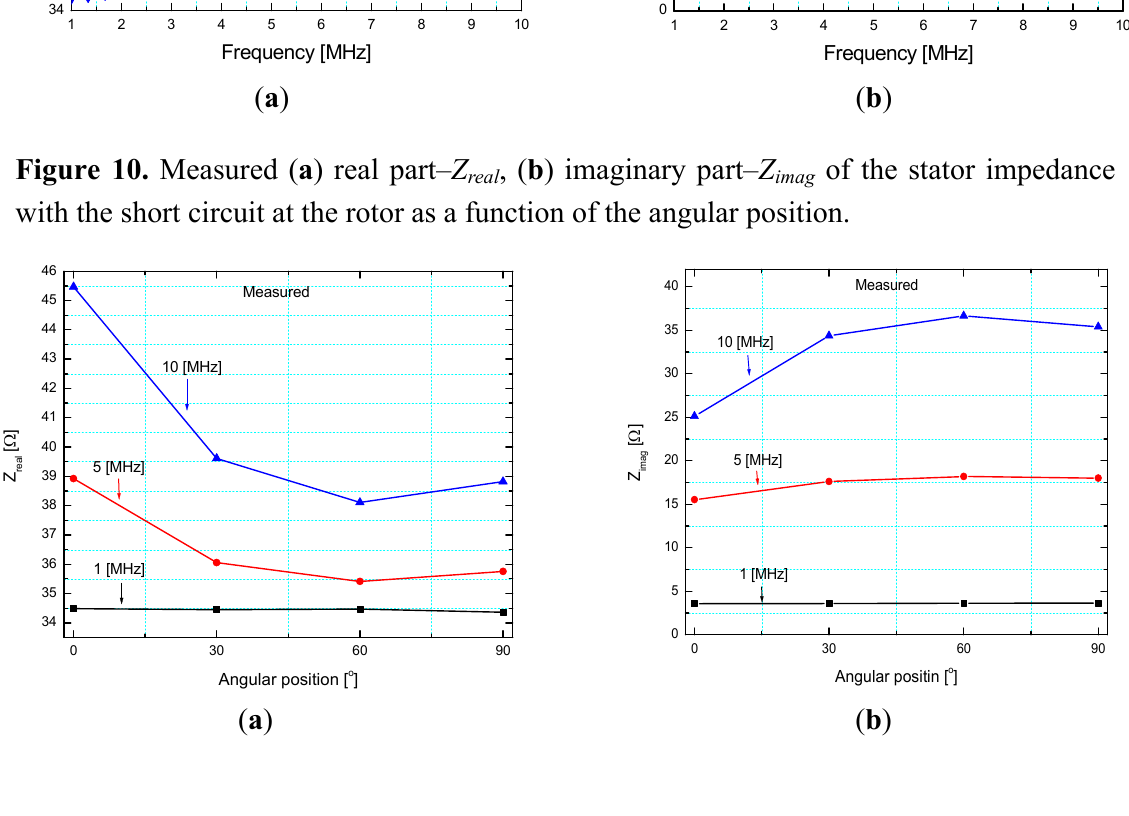
; ( b ) imaginary part– Z of the stator impedance real imag